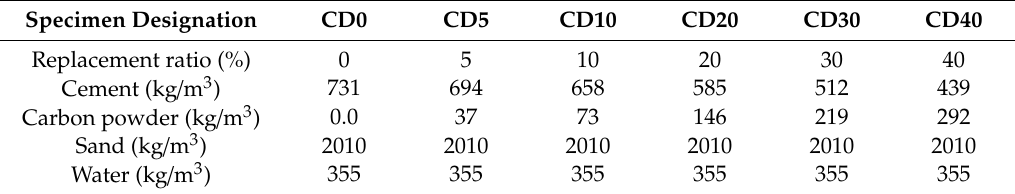
Table 3. Mix proportions and specimen’s designation.